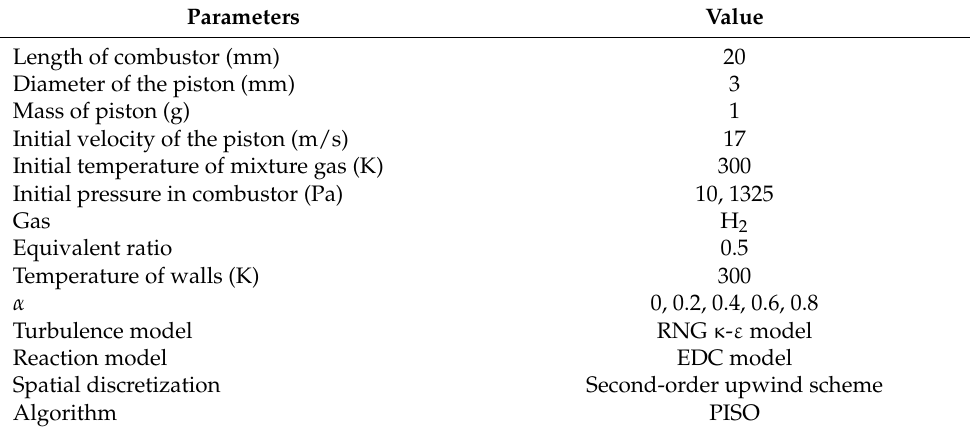
Table 3. Numerical simulation conditions and solver